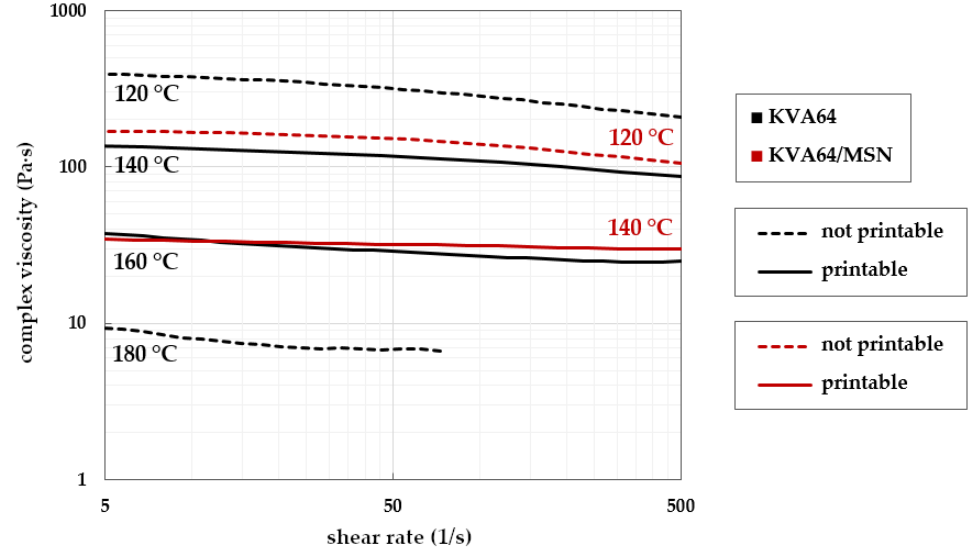
Figure 6. Complex viscosities of placebo formulation KVA64/PEG (black lines) and KVA64/PEG/MSN (red lines) in relation to shear rate monitored at different temperatures; temperatures for successful print runs are symbolized by continuous lines, unsuitable print runs in dotted lines.